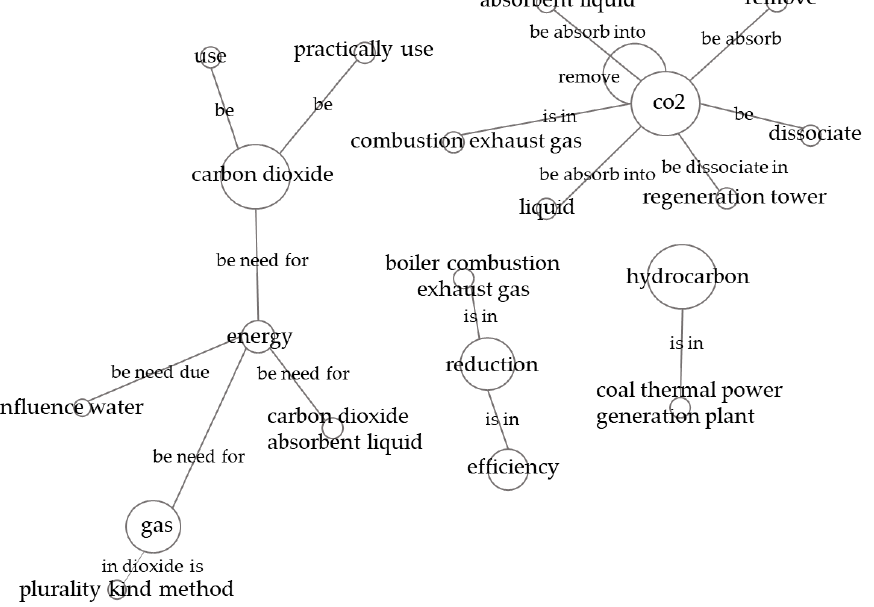
Figure 7. Summary graph of US10722838B2.